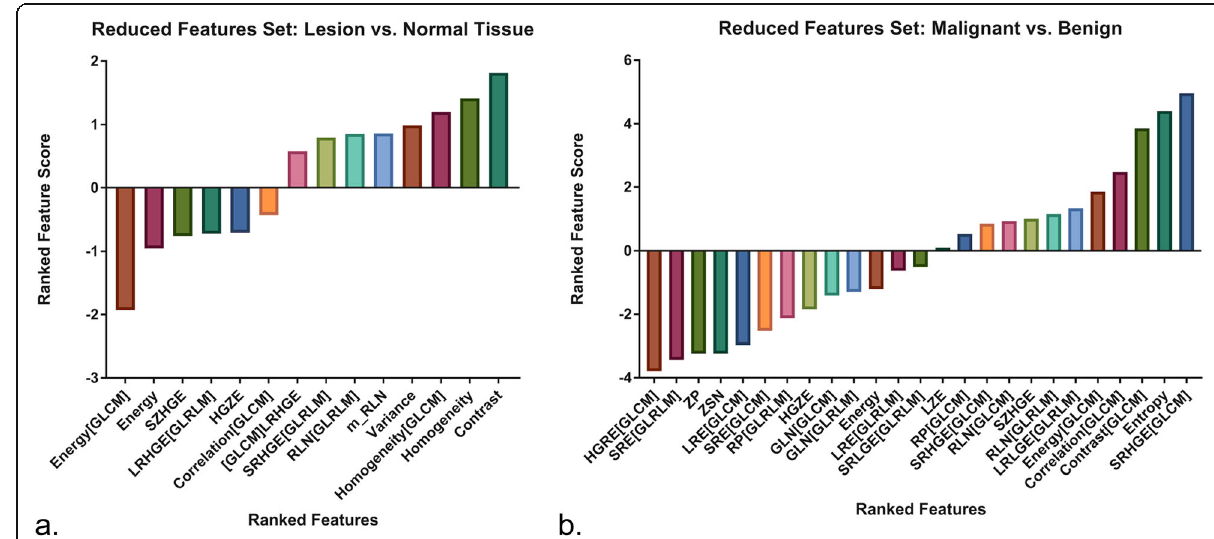
Fig. 4 Ranked feature score in subset i ( a ) and in subset ii ( b ) (see